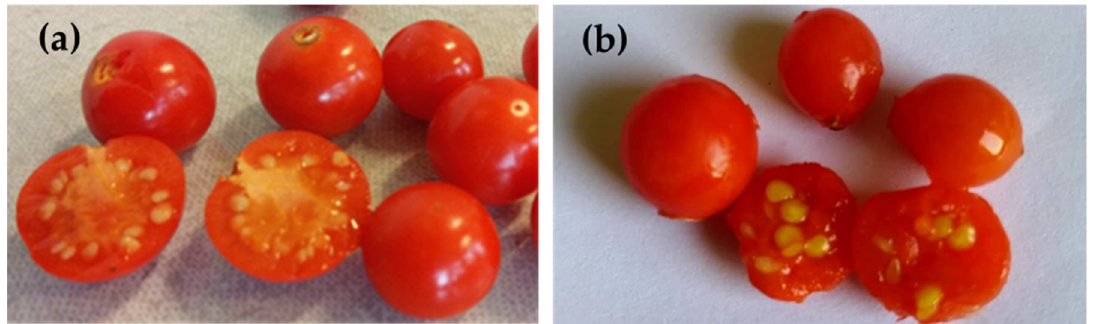
Figure 1. Fresh fruits of P. alkekengi : ( a ) PA-SB phenotype from Central Southern Bulgaria; ( b ) PA-NB phenotype from North-Eastern Bulgaria. Photos by authors.